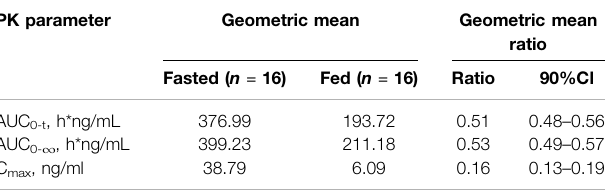
Frontiers in Pharmacology |